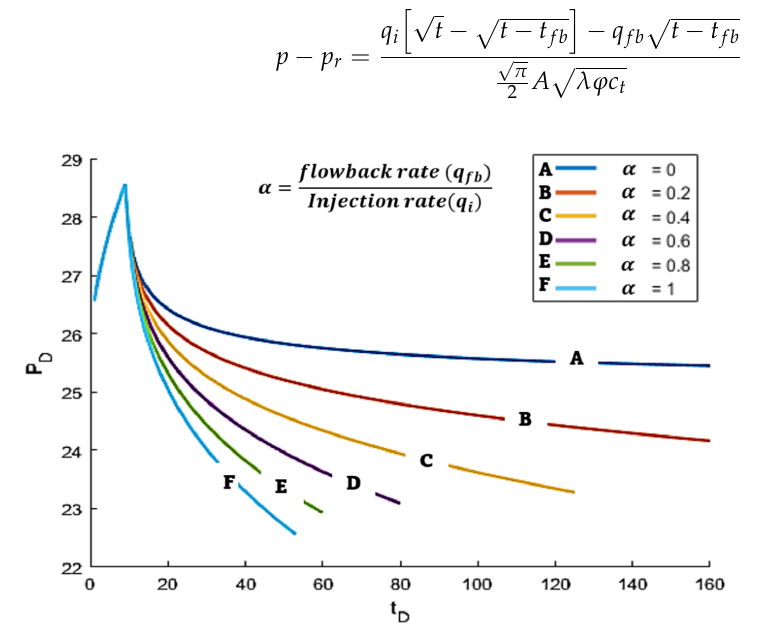
Figure 8. The solution type curve for different flowback/injection